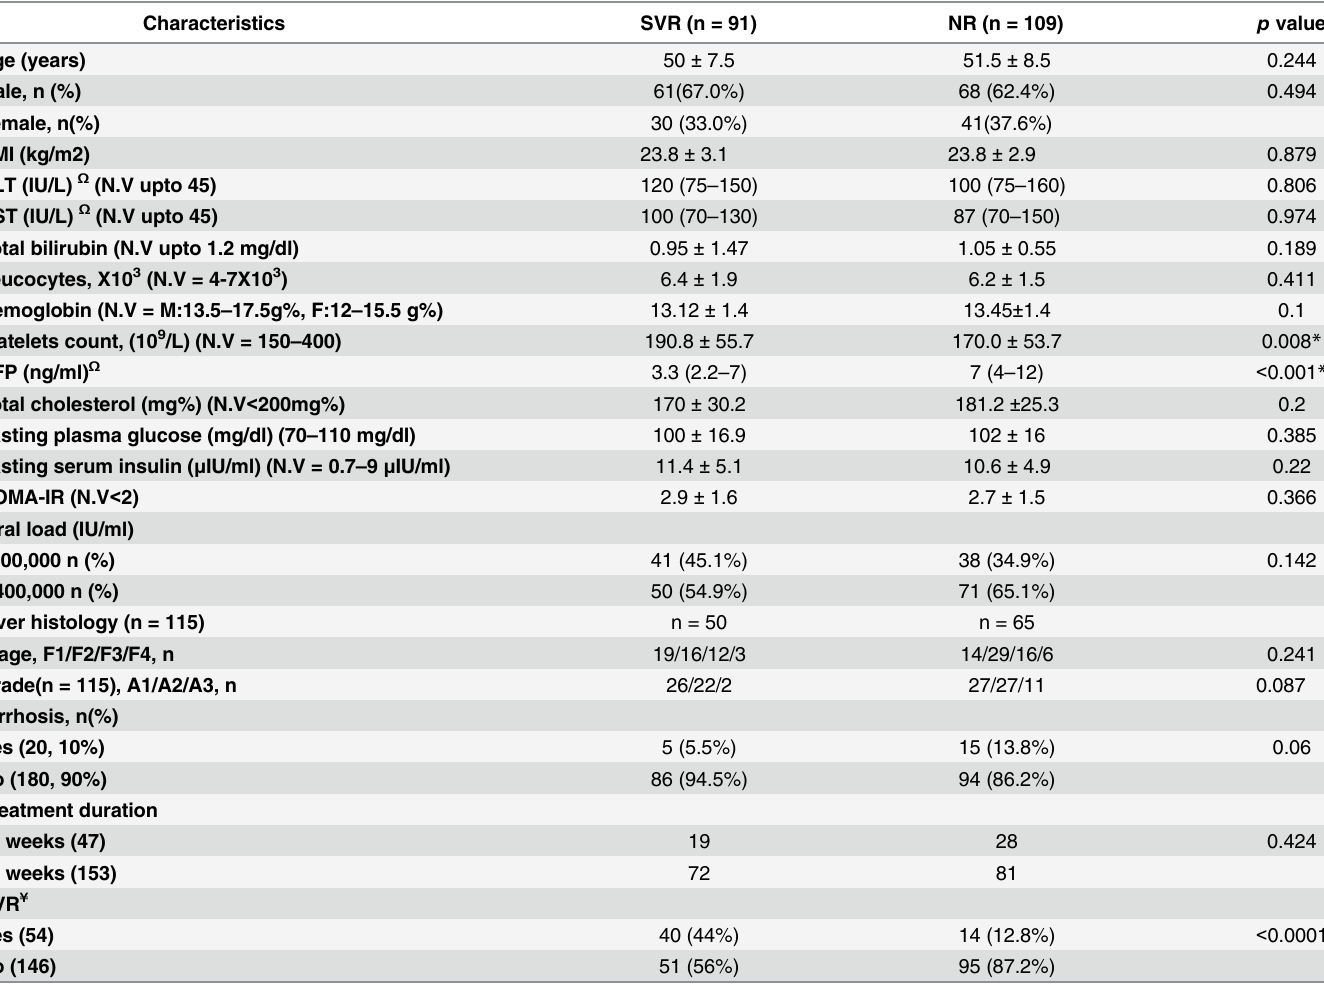
Table 1. Baseline demographic, clinical and virological characteristics of HCV infected study population.